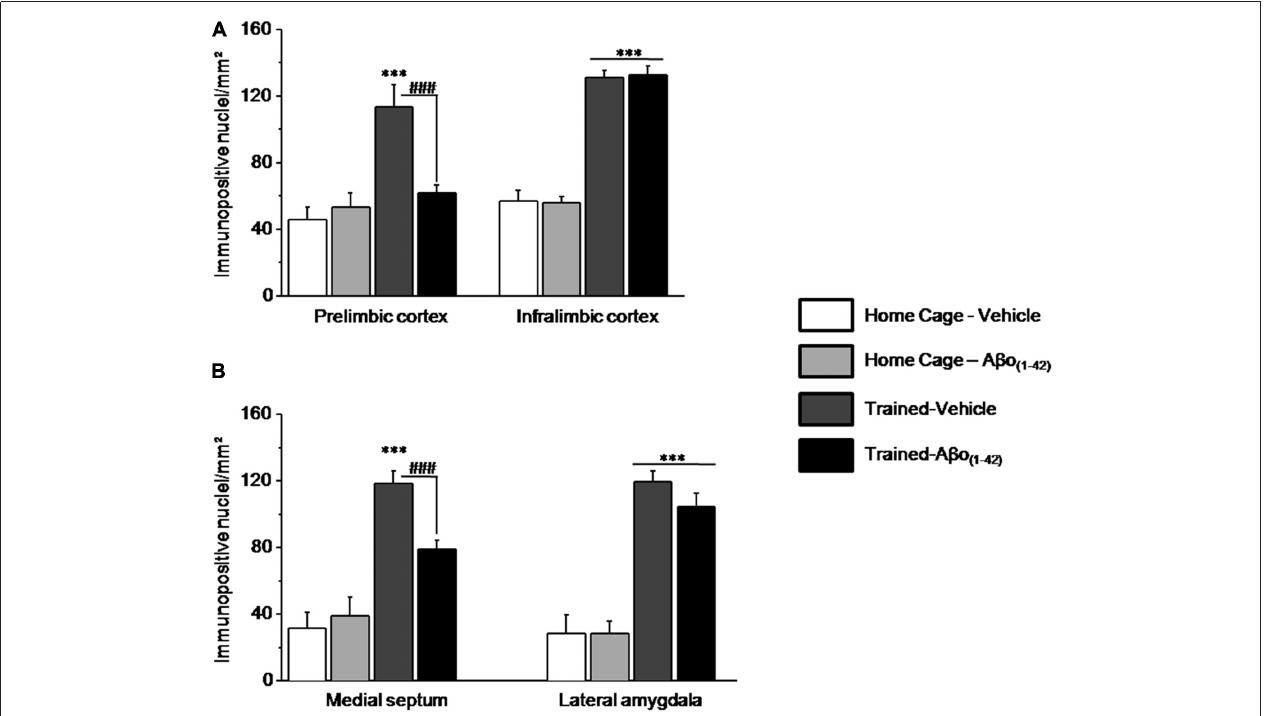
FIGURE 7 | Effects of intra-dCA1 A β o ( 1 – 42 ) injections on levels of pERK in other structures related to the hippocampus . The same animals as depicted in Figure 6 were used for these analyses. (A) In the mPFC, levels of pERK were measured in the prelimbic (PL) and infralimbic (IL) cortices. Intra-dCA1 A β o ( 1–42 ) injections abolished tested-related increase in pERK only in the PL. (B) In the septum, pERK1/2 levels were inhibited by dCA1 infusions of A β o ( 1–42 ) . In the lateral amygdala (LA), A β o ( 1–42 ) had no effect on pERK, regardless of home-cage or tested conditions. ∗∗∗ : Test effect ; ### : Between-group